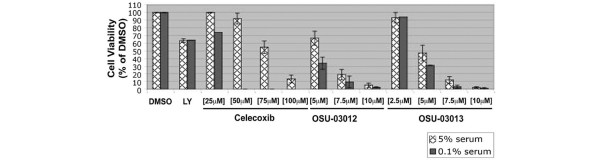
Effect of serum on the cytotoxicity of celecoxib and its analogues. MDA-MB-453 cells were treated with dimethyl sulphoxide (DMSO), Ly294002, celecoxib, OSU03012, or OSU03013 in either 5% foetal bovine serum/RPMI 1640 or 0.1% foetal bovine serum/RPMI 1640. Cell survival was measured 24 hours later using the MTT assay. Each of the treatments were tested in replicates of four and repeated twice.